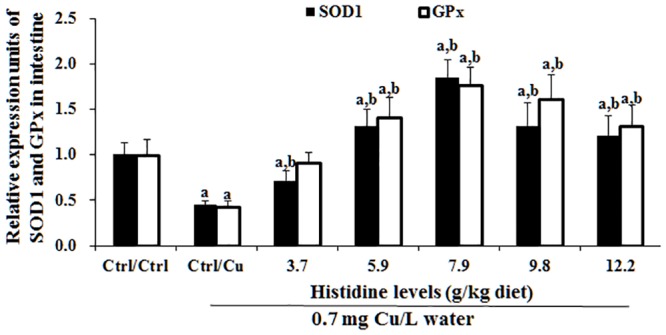
Cu induces increases in SOD1 and GPx mRNA levels in the entire intestine of grass carp. The protocol and indications are shown in Fig 3.SOD1, copper, zinc-superoxide dismutase; GPx, glutathione peroxidase.